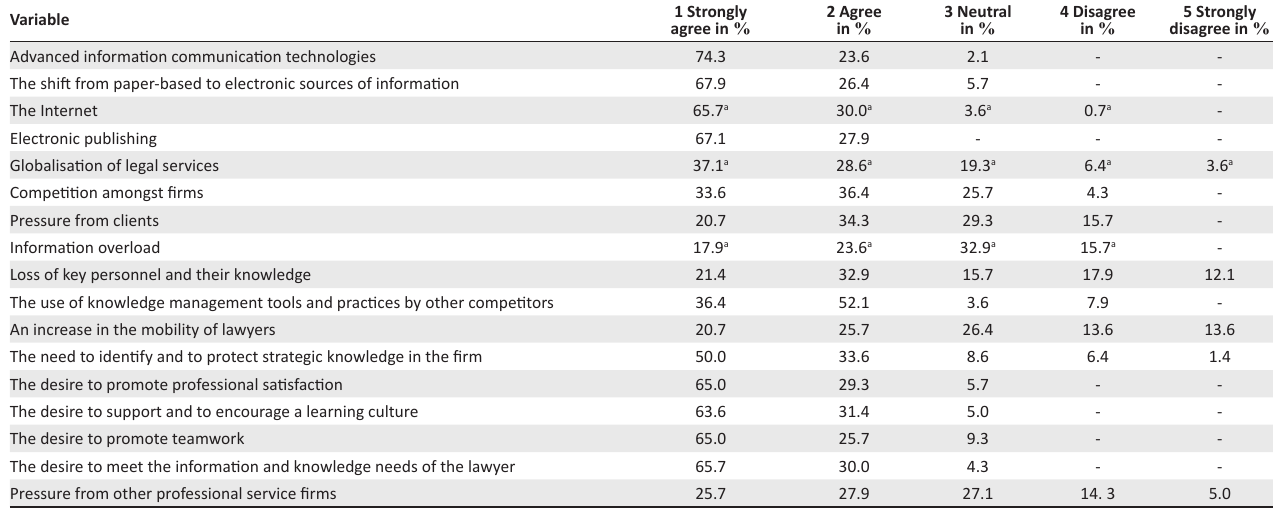
TABLE 1: What would motivate the adoption of knowledge management in your firm? ( N = 140).